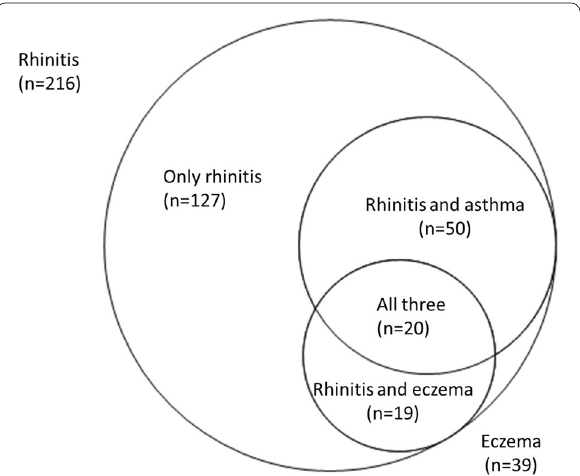
Fig. 2 Asthma and eczema in participants with rhinitis. *The distribution of rhinitis subjects (n (n 39) within different =